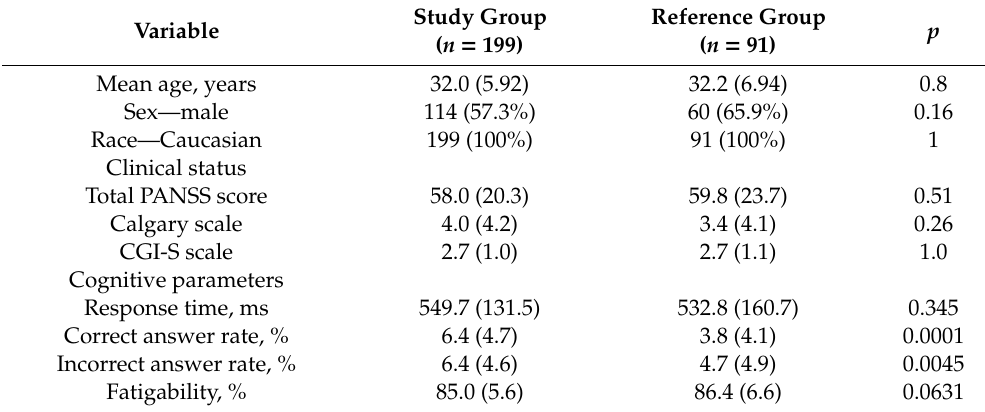
Table 1. Baseline characteristics of the